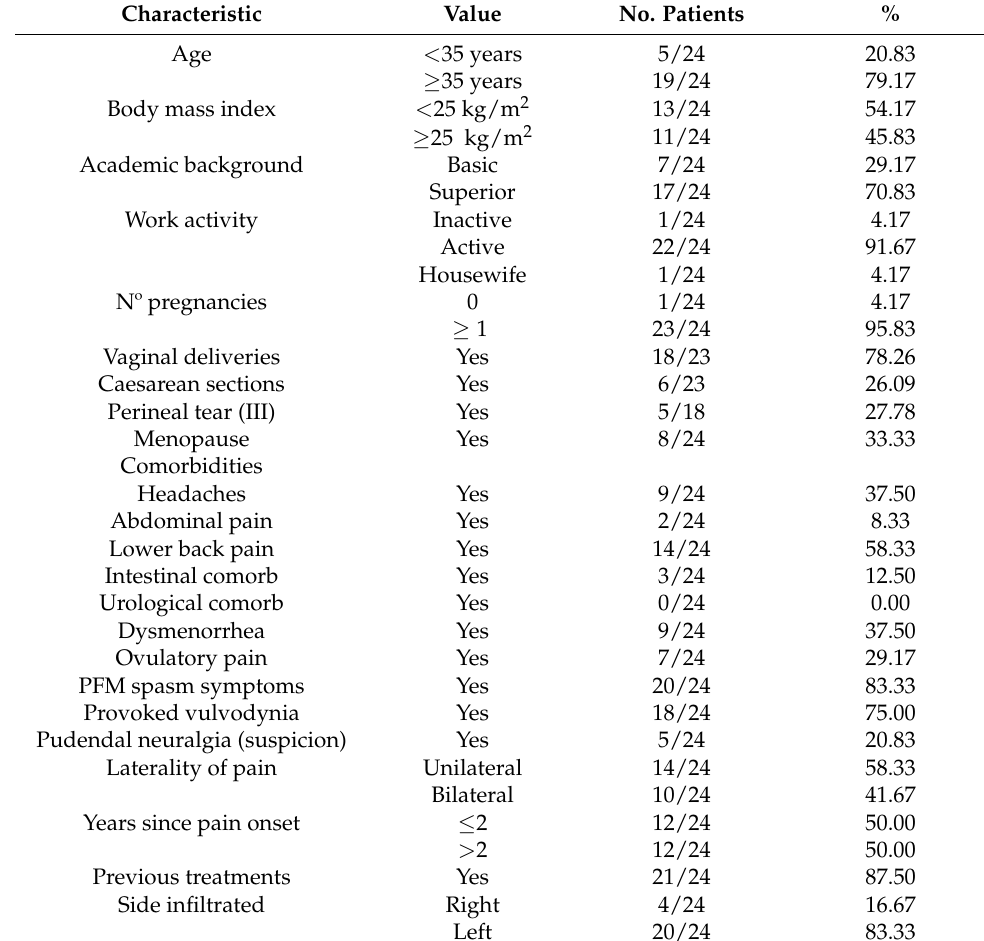
Table 1. Patients’ sociodemographic, anthropomorphic and clinical characteristics at